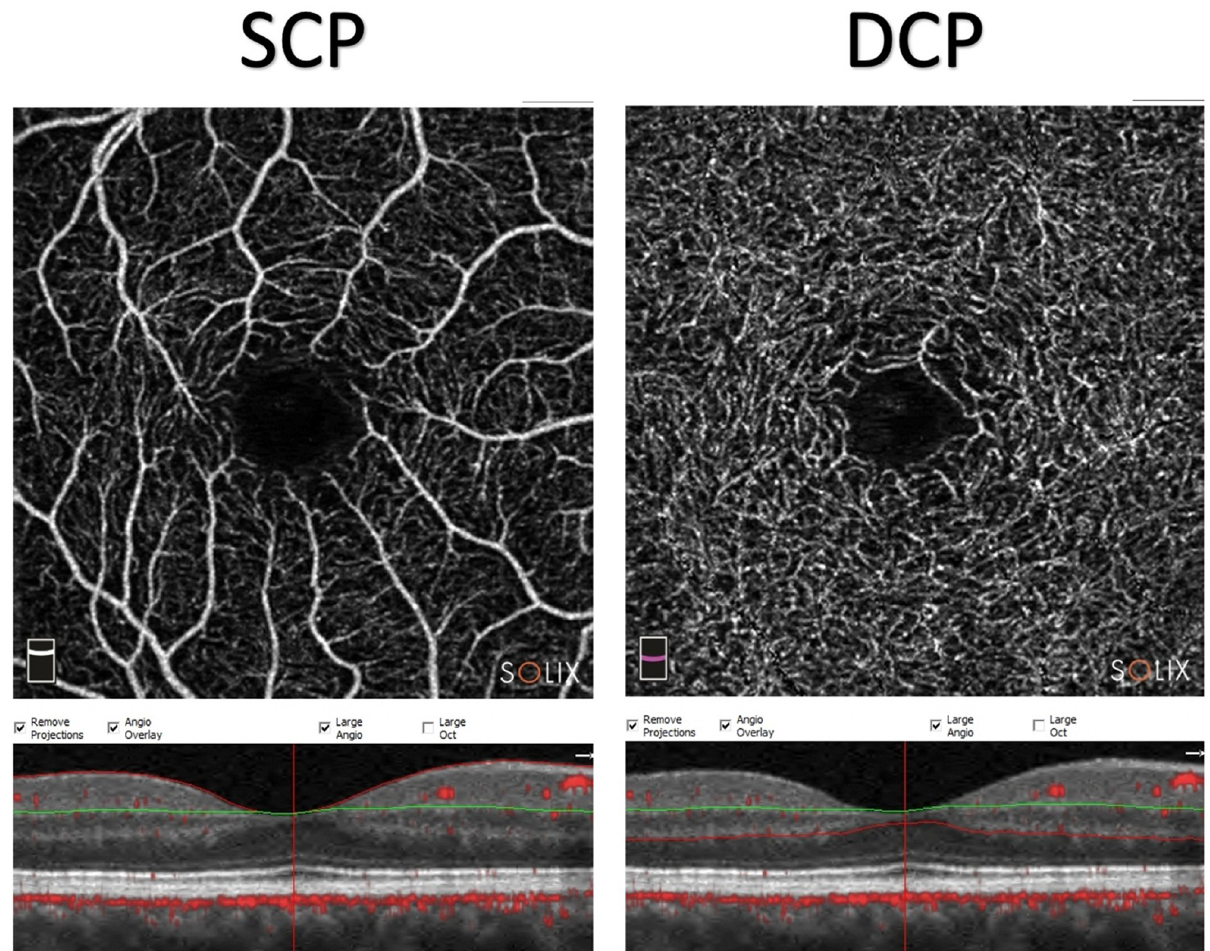
Fig 1. Representation of the structural SD-OCT layers segmentation for superficial capillary plexus (SCP) and deep capillary plexus